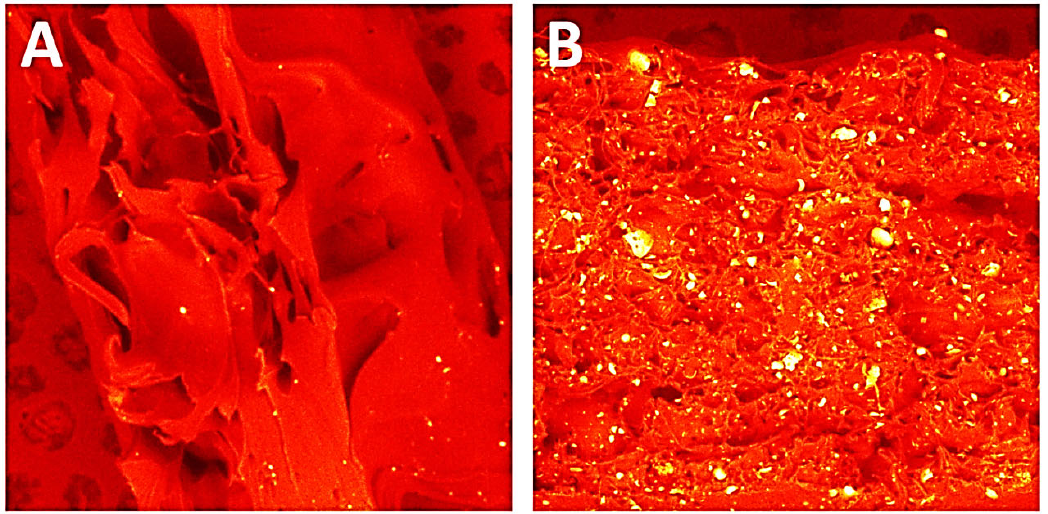
Figure 16. Dispersion of ceramic fillers in the polymer matrix for ( A ) PA12_NS and ( B ) PA12_CS_S samples. Visible impurities from the zirconia injection moulding process were found in PA12 samples.